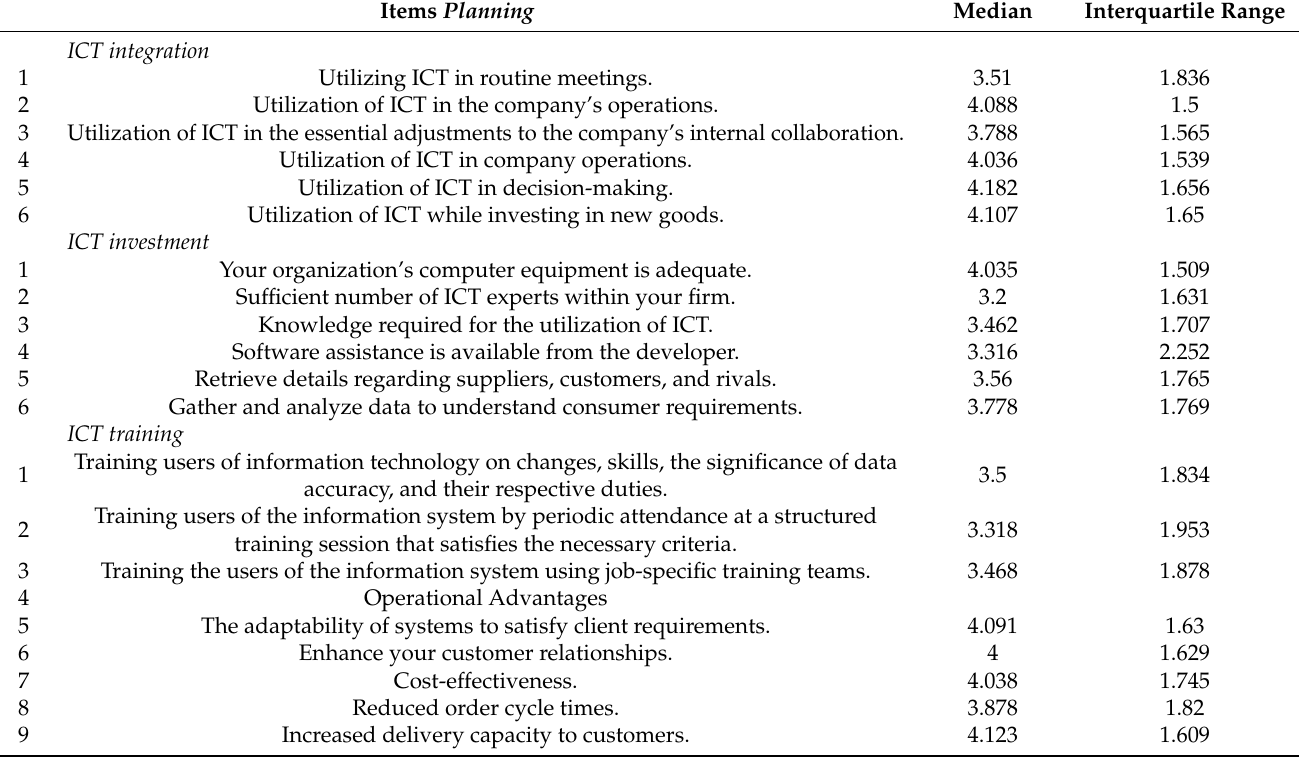
Table 4. Descriptive analysis of the